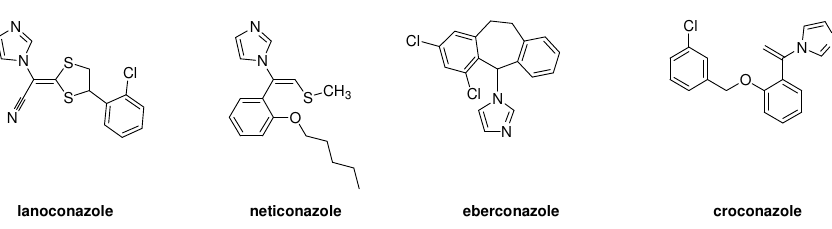
Figure 9. Topical non-miconazole-like